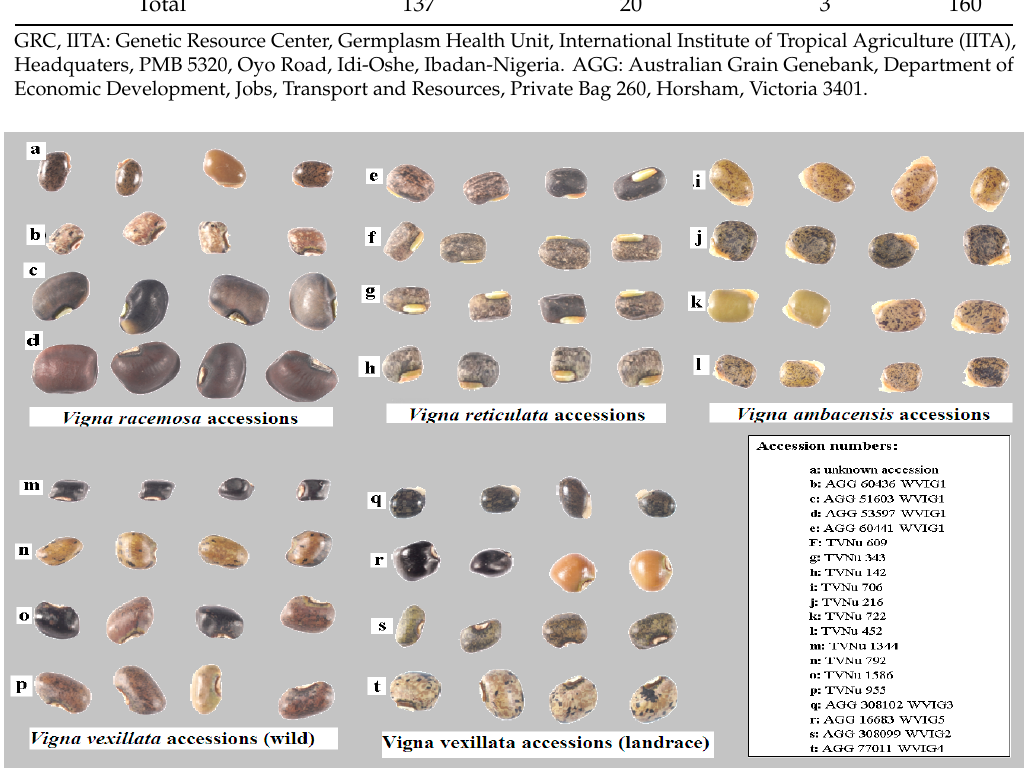
Figure 2. Microphotographs illustrating seed morphology of some wild Vigna species; Four (4) seeds per accession were pictured under the same conditions to give an image of the morphology and the relative size. Distances of lines in the background are 1 cm in the vertical and horizontal directions.